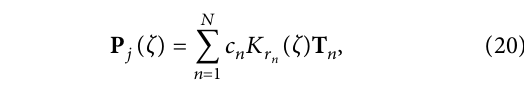
f / ω 0 with respect to